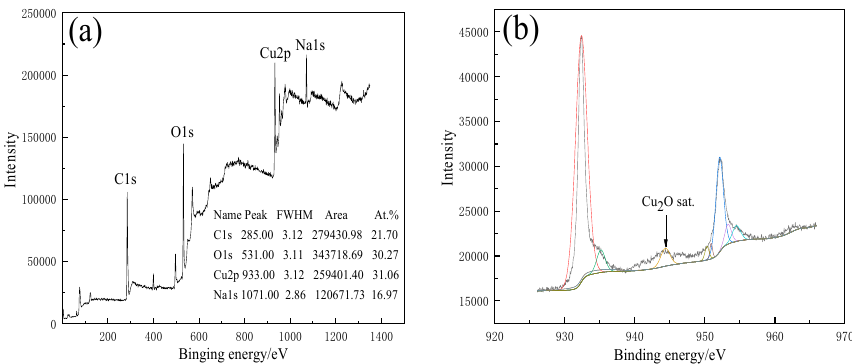
Figure 8. XPS spectra of the degummed braided carbon fiber rope: ( a ) survey XPS spectra; ( b ) C1s spectra.